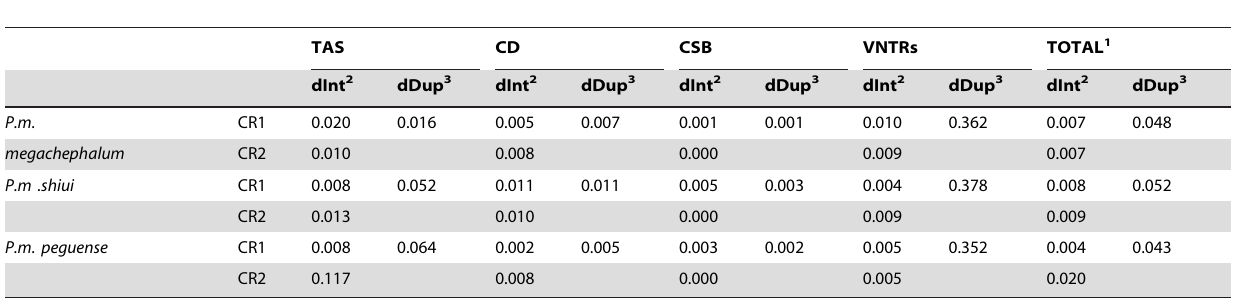
Table 3. Mean genetic distance calculated using MEGA 4.1 software and different parts of CRs.